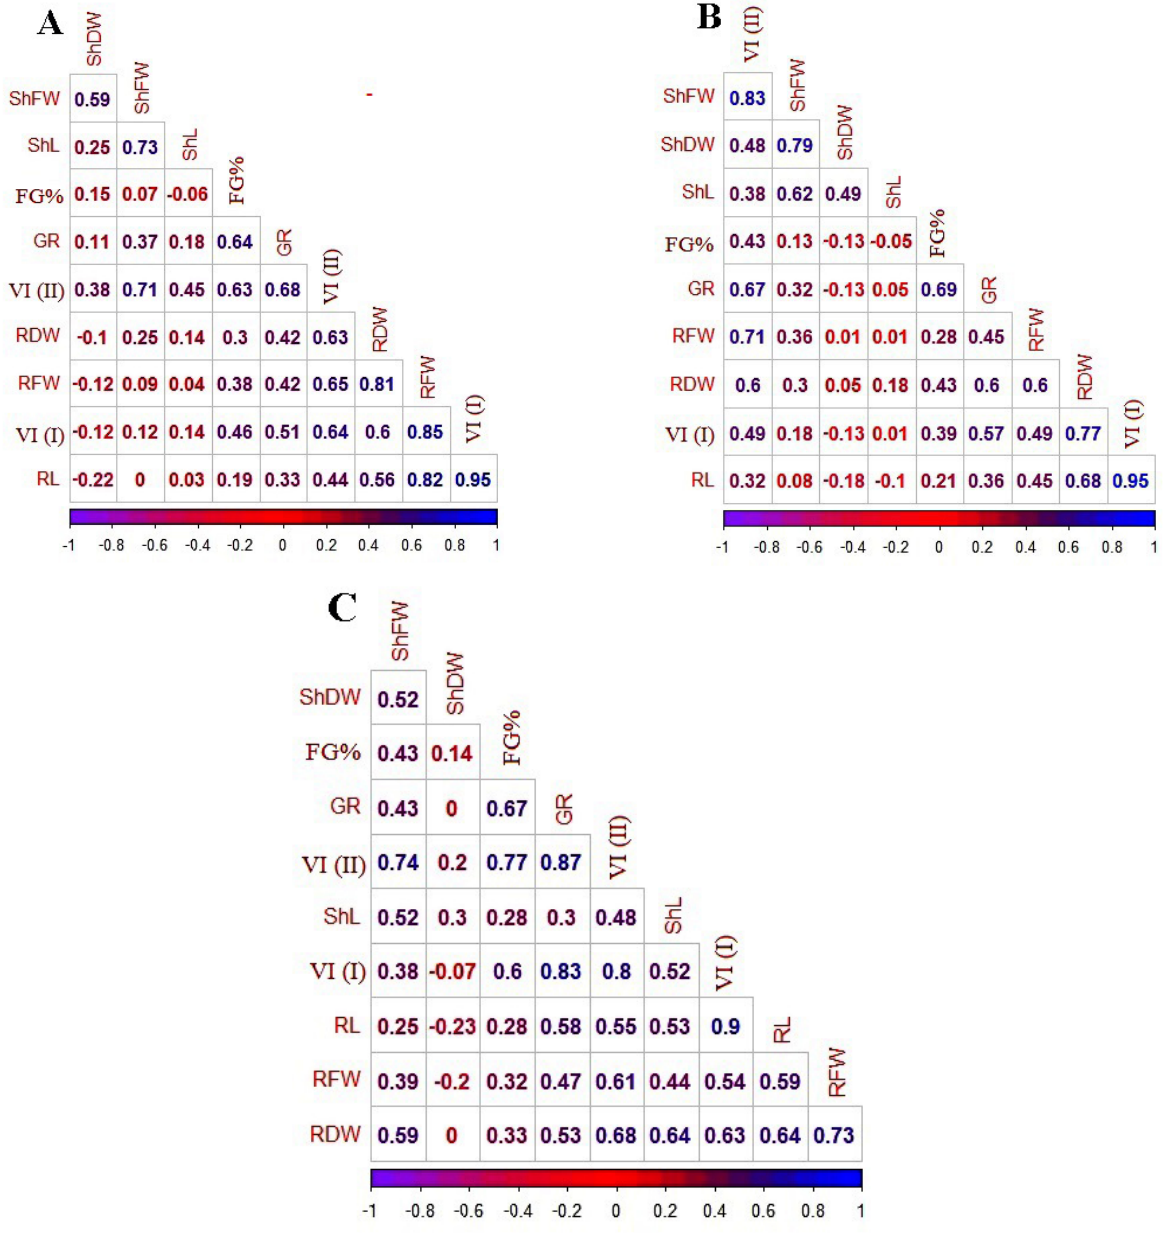
Figure 3. Correlation indicators of rapeseed cultivars based on mean values: under ( A ) control, ( B ) 10% PEG-6000 and ( C ) 15% PEG-6000.